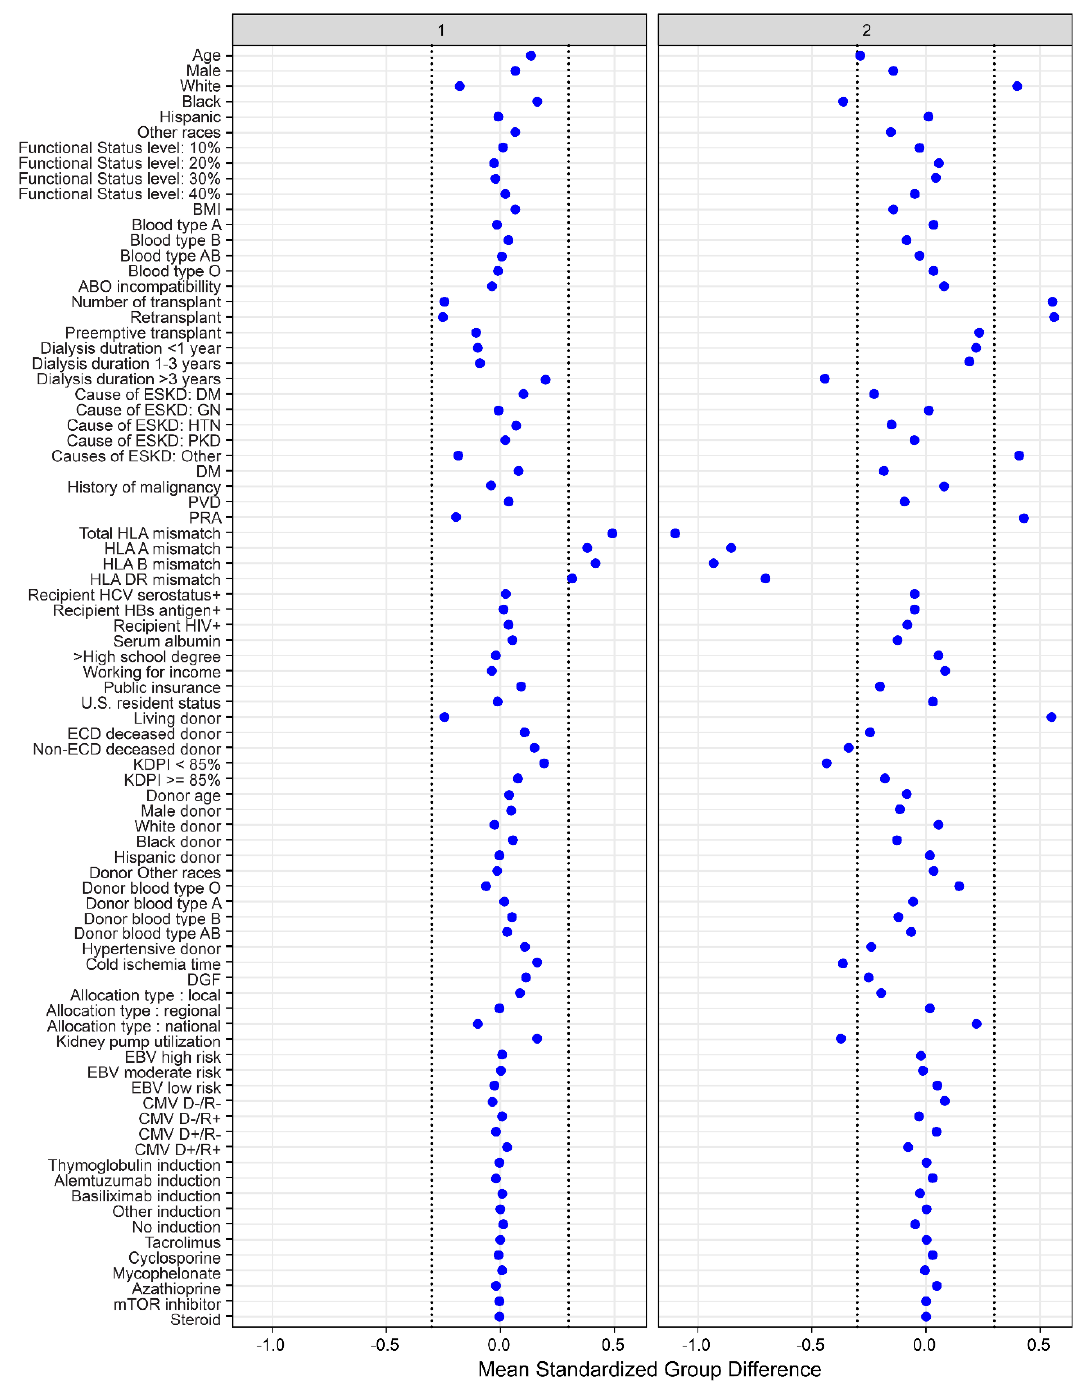
Figure 3. The standardized differences across two clusters for each of baseline parameters. The x axis is the standardized differences value, and the y axis shows baseline parameters. The dashed vertical lines represent the standardized differences cutoffs of < − 0.3 or >0.3. Abbreviations: BMI: Body mass index, CMV: Cytomegalovirus, D: Donor, DGF: Delayed graft function, DM: Diabetes mellitus, EBV: Epstein–Barr virus, ECD: Extended criteria donor, ESKD: End stage kidney disease, GN: Glomerulonephritis, HBs: Hepatitis B surface, HCV: Hepatitis C virus, HIV: Human immunodeficiency virus, HLA: Human leukocyte antigen, HTN: Hypertension, KDPI: Kidney donor profile index, mTOR: Mammalian target of rapamycin, PKD: Polycystic kidney disease, PRA: Panel reactive antibody, PVD: Peripheral vascular disease, R: Recipient.